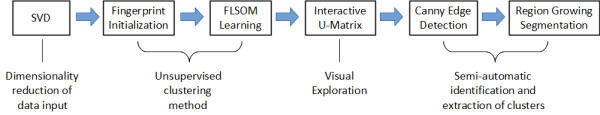
BioDICE diagram block. This diagram shows the six components of the BioDICE plugin.